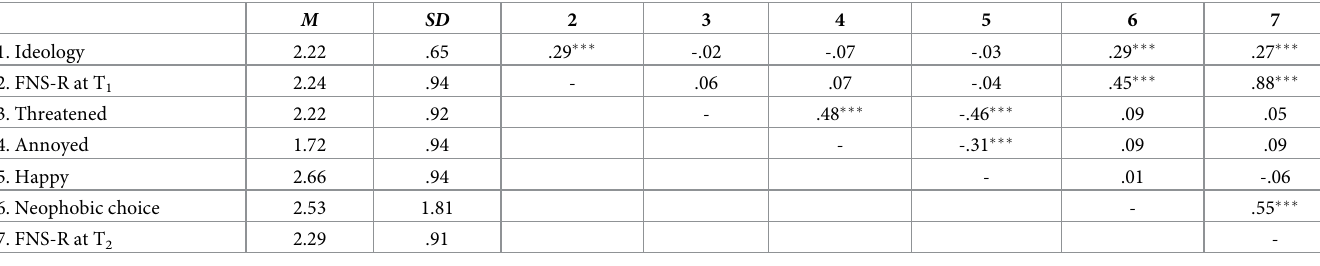
Table 5. Descriptives and correlations for Study 3